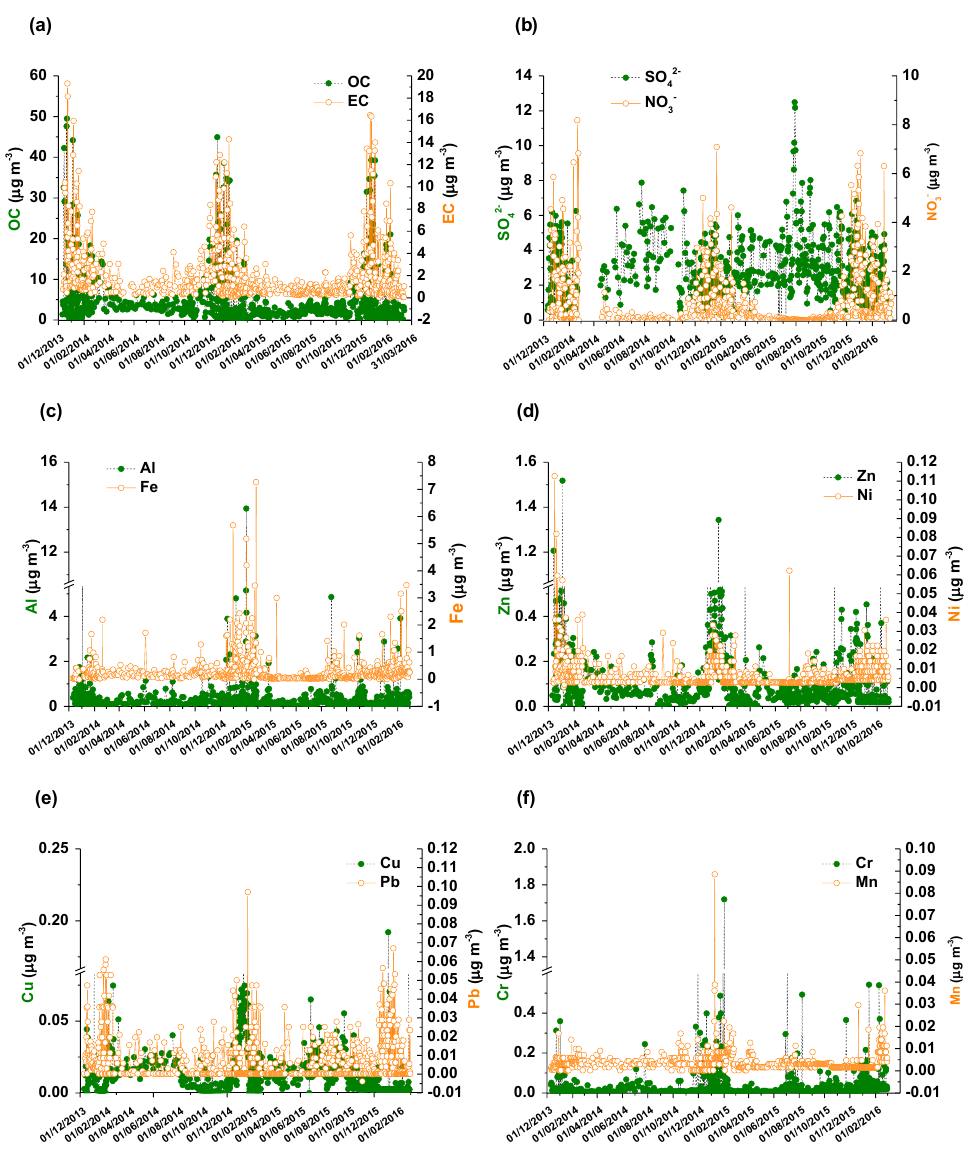
Figure 2. Daily variation of (a) OC, EC, (b) SO 2 −